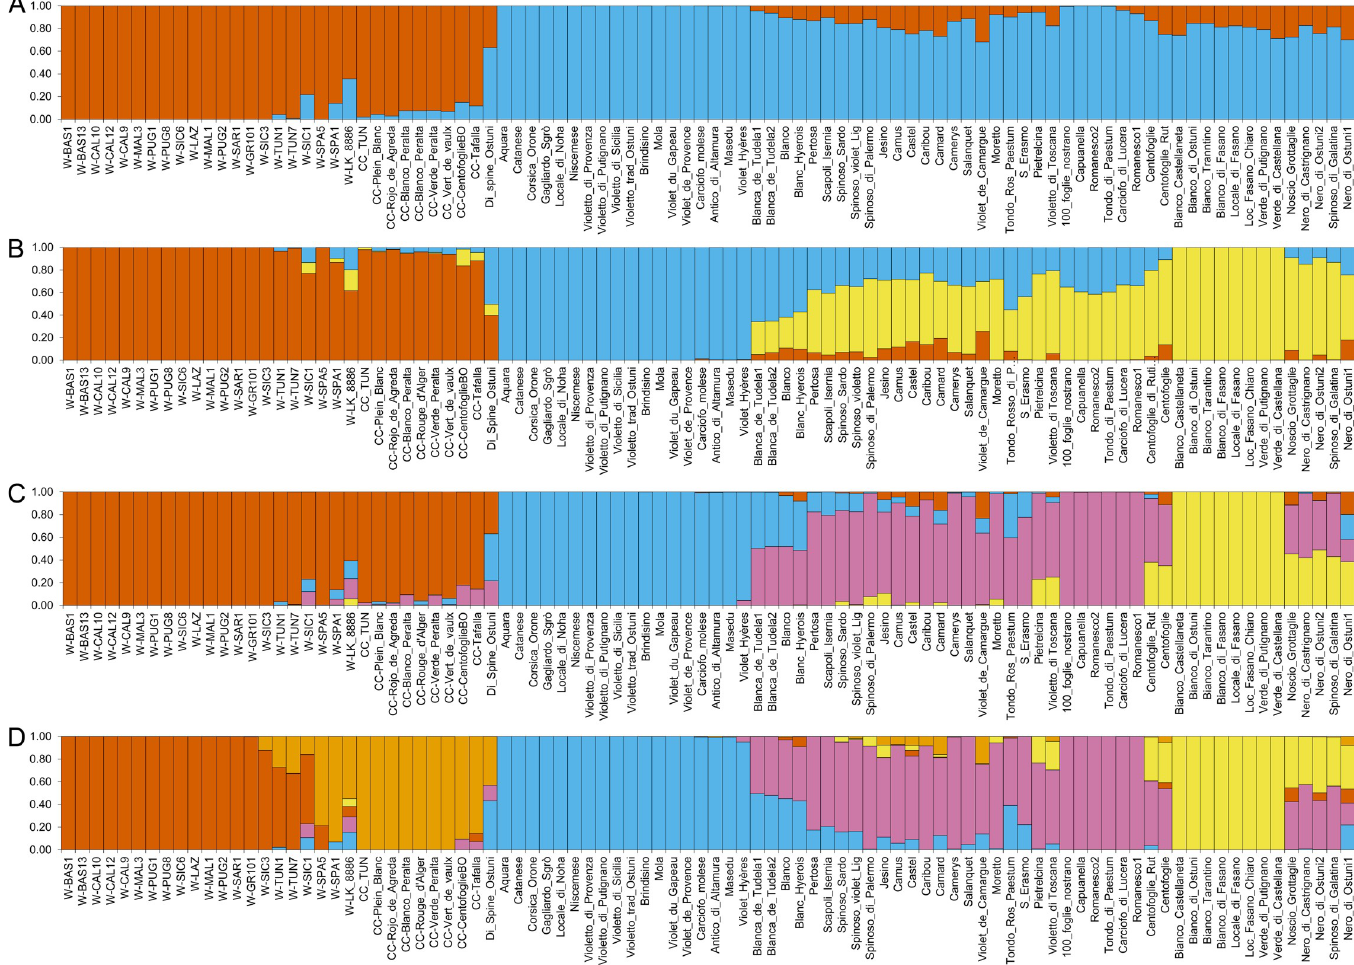
Fig 1. Structure analysis of Cynara cardunculus genotypes. Clusters inferred from the population structure analysis at (A) K = 2, (B) K = 3, (C) K = 4, (D) K = 5. Numbers on the y-axis show the subgroup membership. Genotype names are reported on the x axis. The colours of the bars indicate the groups identified through the STRUCTURE